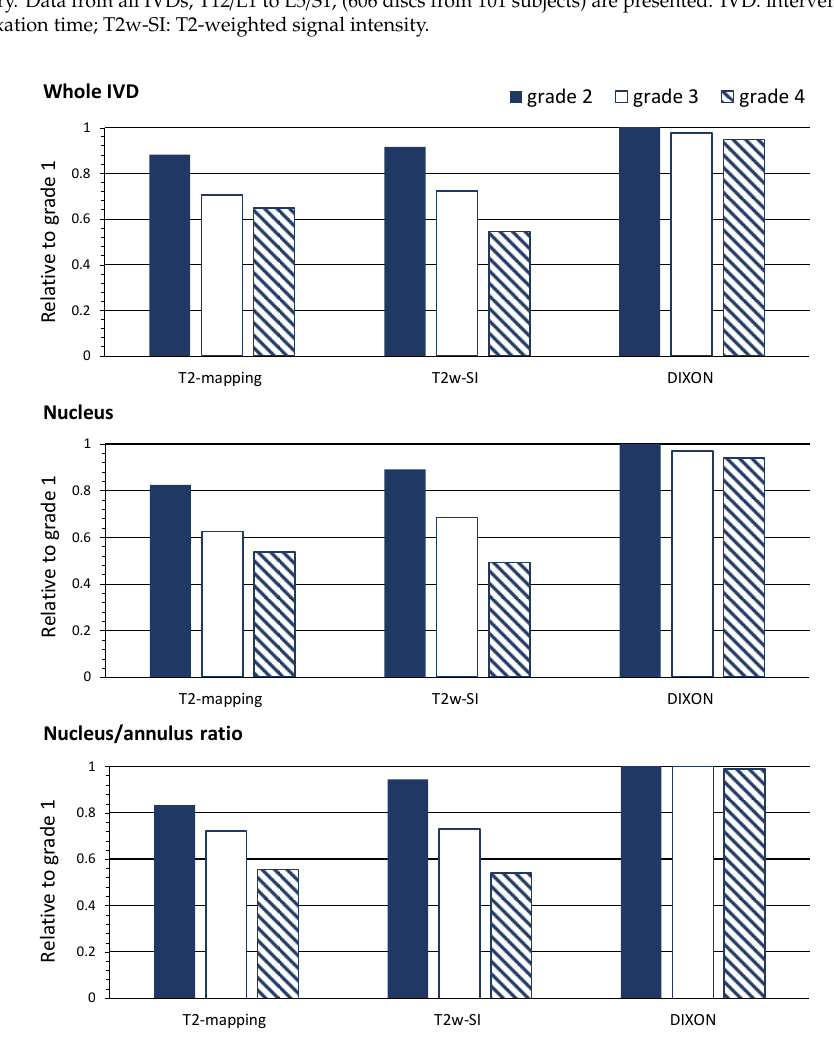
Figure 4. Differences of each MRI technique in quantifying the intervertebral disc. Data are relative differences in Pfirrmann grades 2, 3 and 4 compared to grade 1. See Table 2 for statistical comparisons.